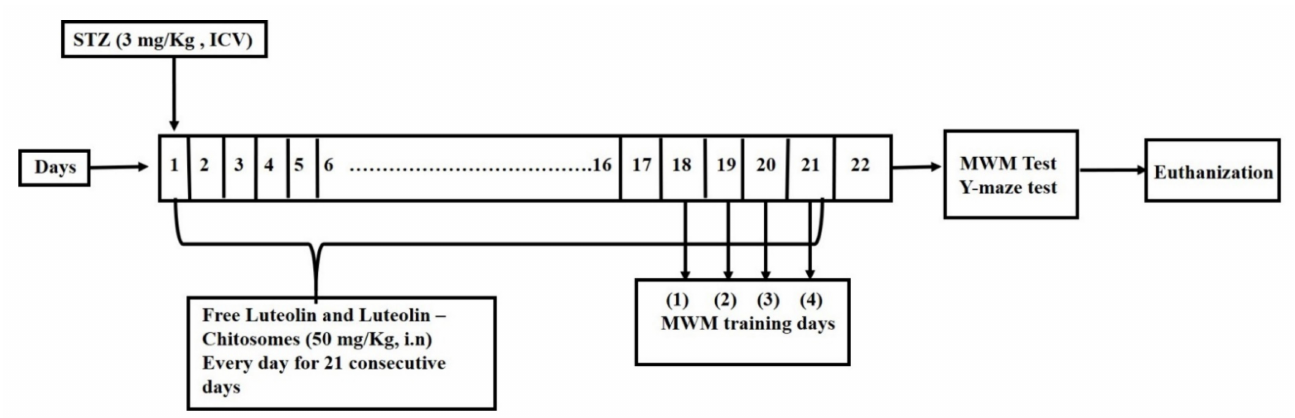
Figure 1. A schematic representation for the experimental